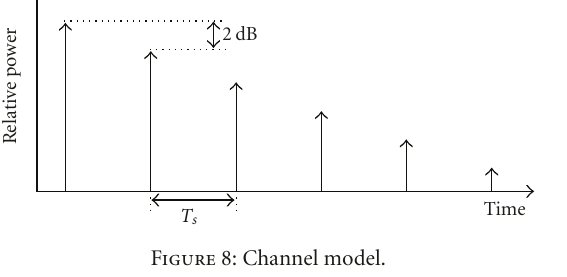
Table 3: Values for m k in